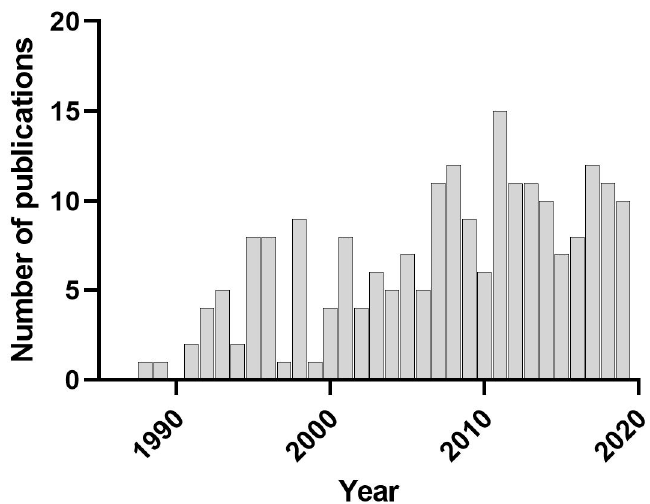
Figure 1. The number of publications that consider indirect effects published in nine representative environmental toxicology journals from 1988 (the first year the search term returned a publication) to 2019. The journals are Environmental Toxicology and Chemistry, Ecotoxicology, Marine Pollution Bulletin, Archives of Environmental Contamination and Toxicology, Environmental Pollution, Bulletin of Environmental Contamination and Toxicology, Environmental Toxicology, Ecotoxicology and Environmental Safety, and Aquatic Toxicology. A Web of Science advanced search was preformed using search terms “indirect effects” AND the various “source titles” in September 2020. Publications that use the term “indirect effects” but were unrelated to effects at the population, community, or ecosystem level were excluded from the count.